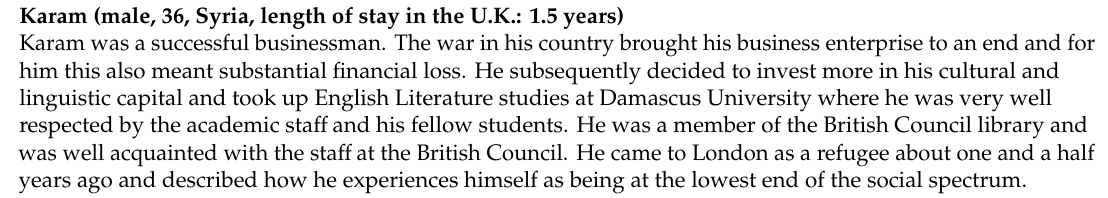
Table 1. An overview of relevant background information on the research